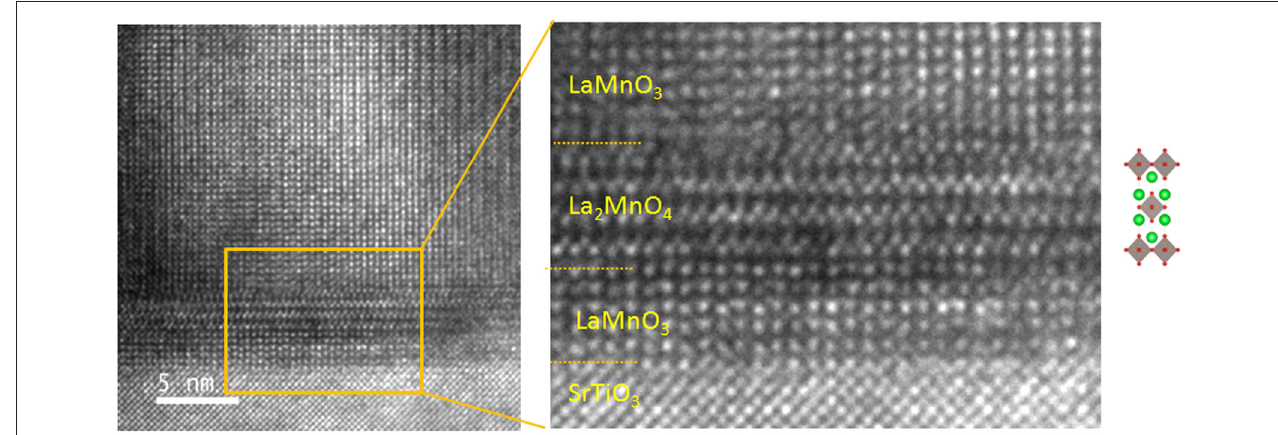
FIGURE 7 | HRTEM images close to the interface between nanocomposite and substrate showing the presence of epitaxial Ruddlesden-Popper La 2 MnO 4